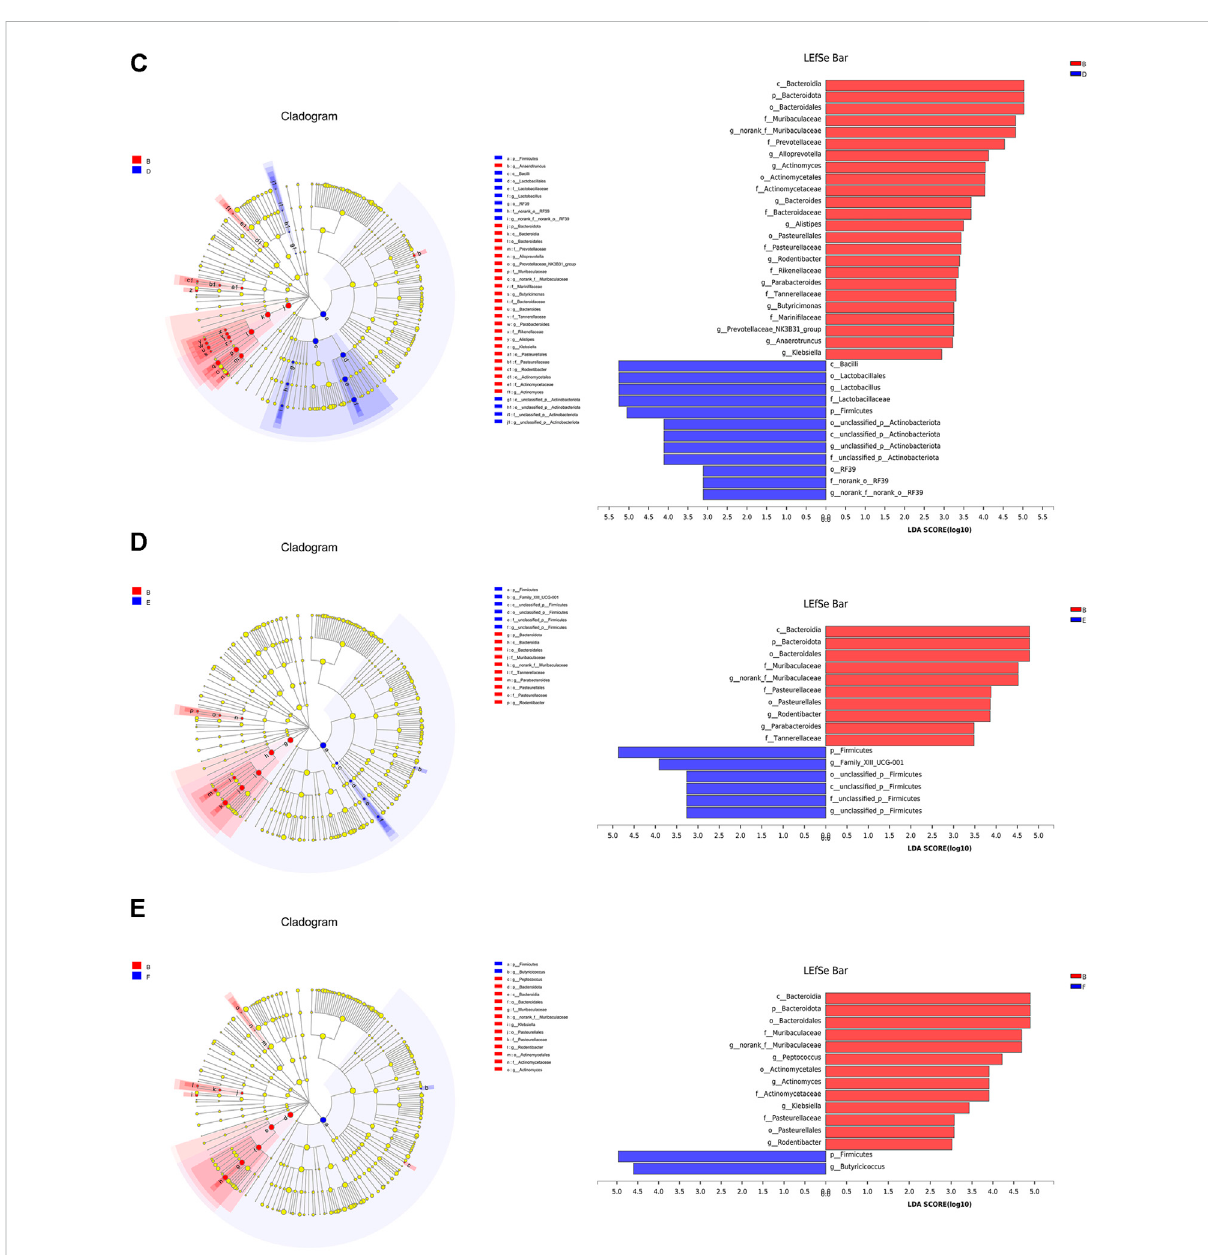
FIGURE 8 Blank group and DN model group (A) , DN model group and irbesartan group (B) , DN model group and Cornus of fi cinalis group (C) , DN model groupandwineCornusof fi cinalisgroup (D) ,DNmodelgroupandwinehoneyCornusof fi cinalisgroup (E) LEfSedifferenceanalysischart.Note: ① A. Blank group B. DN model group C. Irbesartan group D. Cornus of fi cinalis group E. Wine Cornus of fi cinalis group F. Wine honey Cornus of fi cinalis groupG.AuxiliarywinegroupH.Auxiliarywinehoneygroup. ② Differentcolornodesrepresentmicrobialgroupsthat aresigni fi cantly enriched in thecorresponding groups and have a signi fi cant effect on the differences between groups; light yellow nodes indicate microbial groups that have no signi fi cant difference in different groups or have no signi fi cant effect on the difference between groups. If the number of signi fi cantly